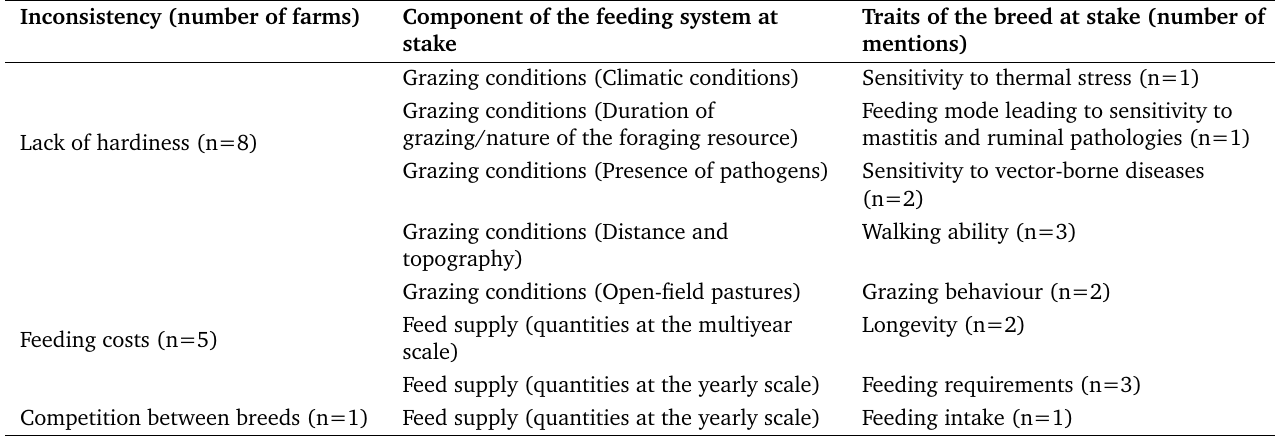
Table 3. Components of the feeding system and the traits of the breed involved in the different forms of inconsistencies mentioned